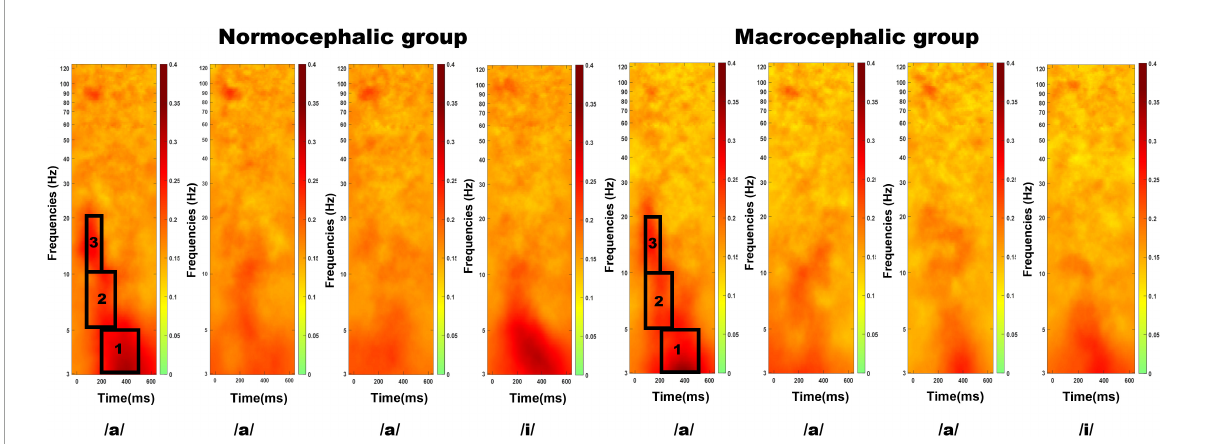
FIGURE2 Central region: Inter-trial phase coherence across the standard sequence/a/a/a/i/by group. The x -axis represents time, while the y -axis displays frequency. Black squares are showing the selected time-frequency windows: (1) 3–5 Hz (200–500 ms); (2) 5–10 Hz (100–300 ms), and (3)10–20 Hz (100–200